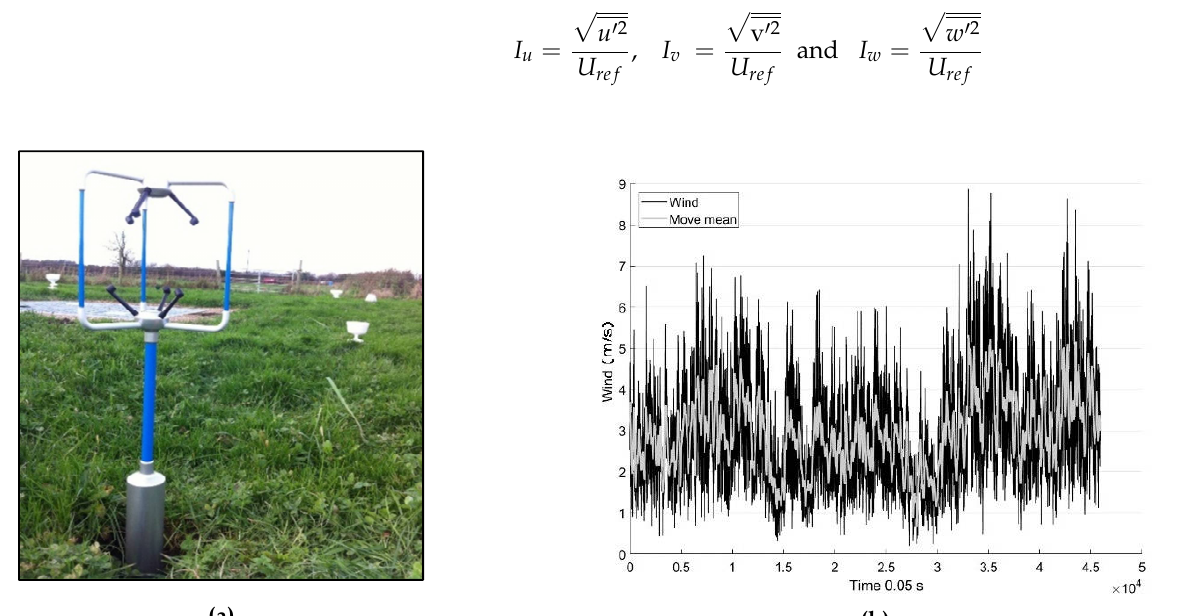
Figure 1. ( a ) The Nafferton (U.K.) field test site with the 3D Sonic anemometer and EML © aerodynamic rain gauges installed at the ground surface, and ( b ) high-frequency wind measurements (black line) and moving average with N = 125 (grey line).